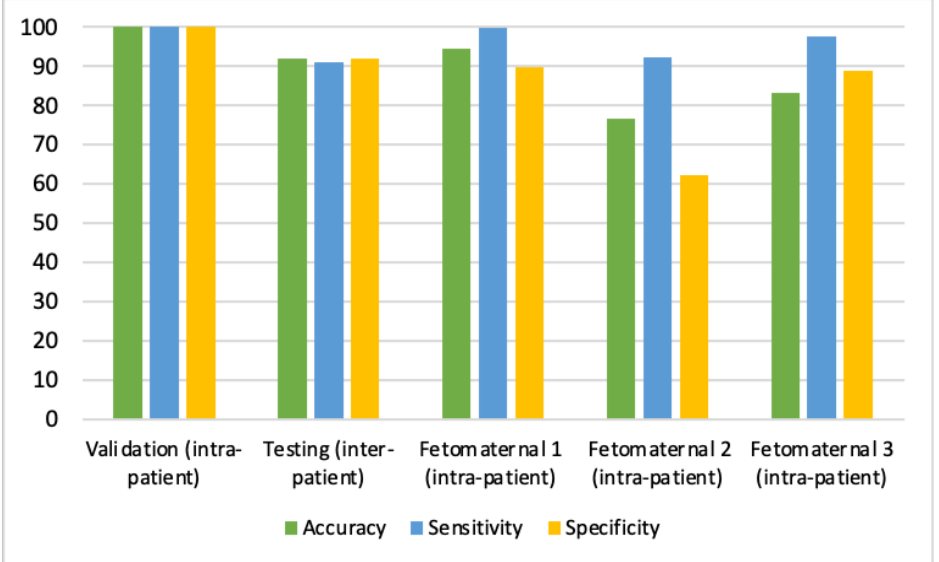
Figure 7. Performance of CHD Prediction Based on Validation (Intra-Patient), Testing (Inter-Patient), and Three Expert Fetal